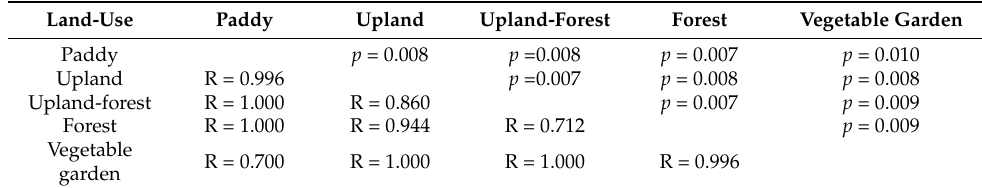
Table 3. One-way ANOSIM analysis of topsoil properties based on Gower distance ( n = 5 for each land-use type).